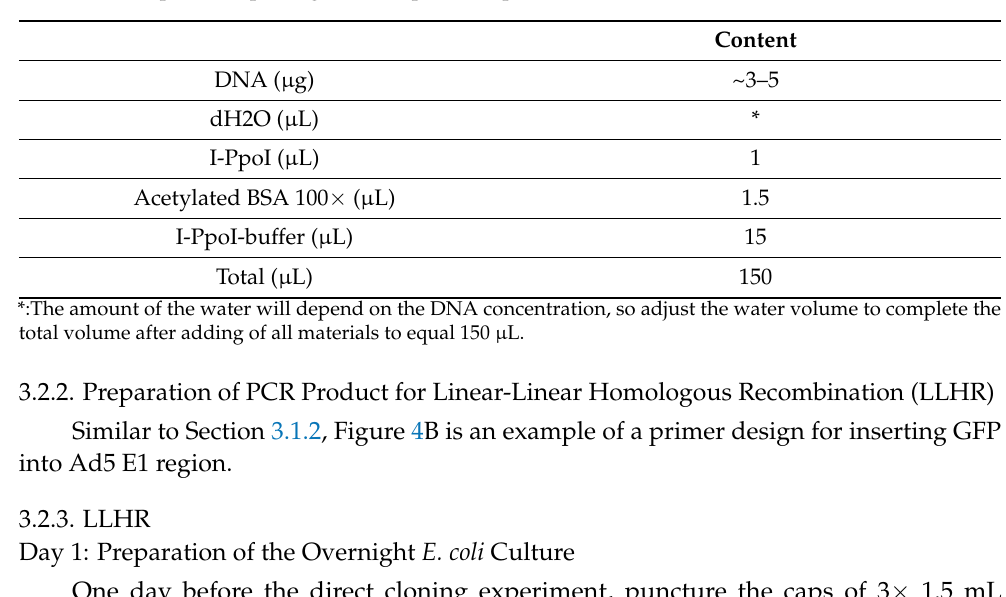
Table 5. Example of I-PpoI digestion of pAd-SM